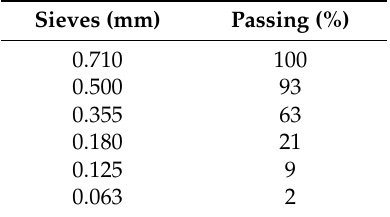
Table 2. Particle size distribution of crumb rubber modifier